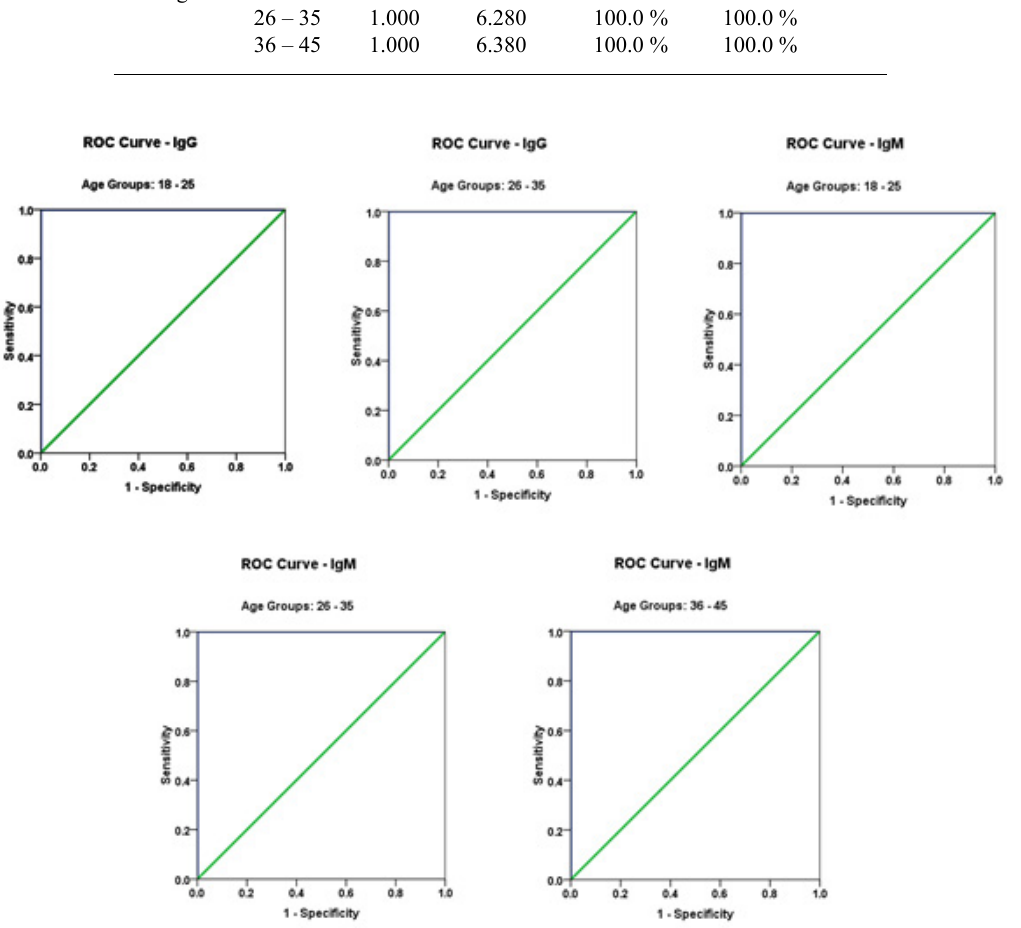
Fig. 3. roC Curve of Igg according the age (18 - 25 and 26 – 35) and IgM according age group of patients 18 - 25 , 26-35 and 36 –